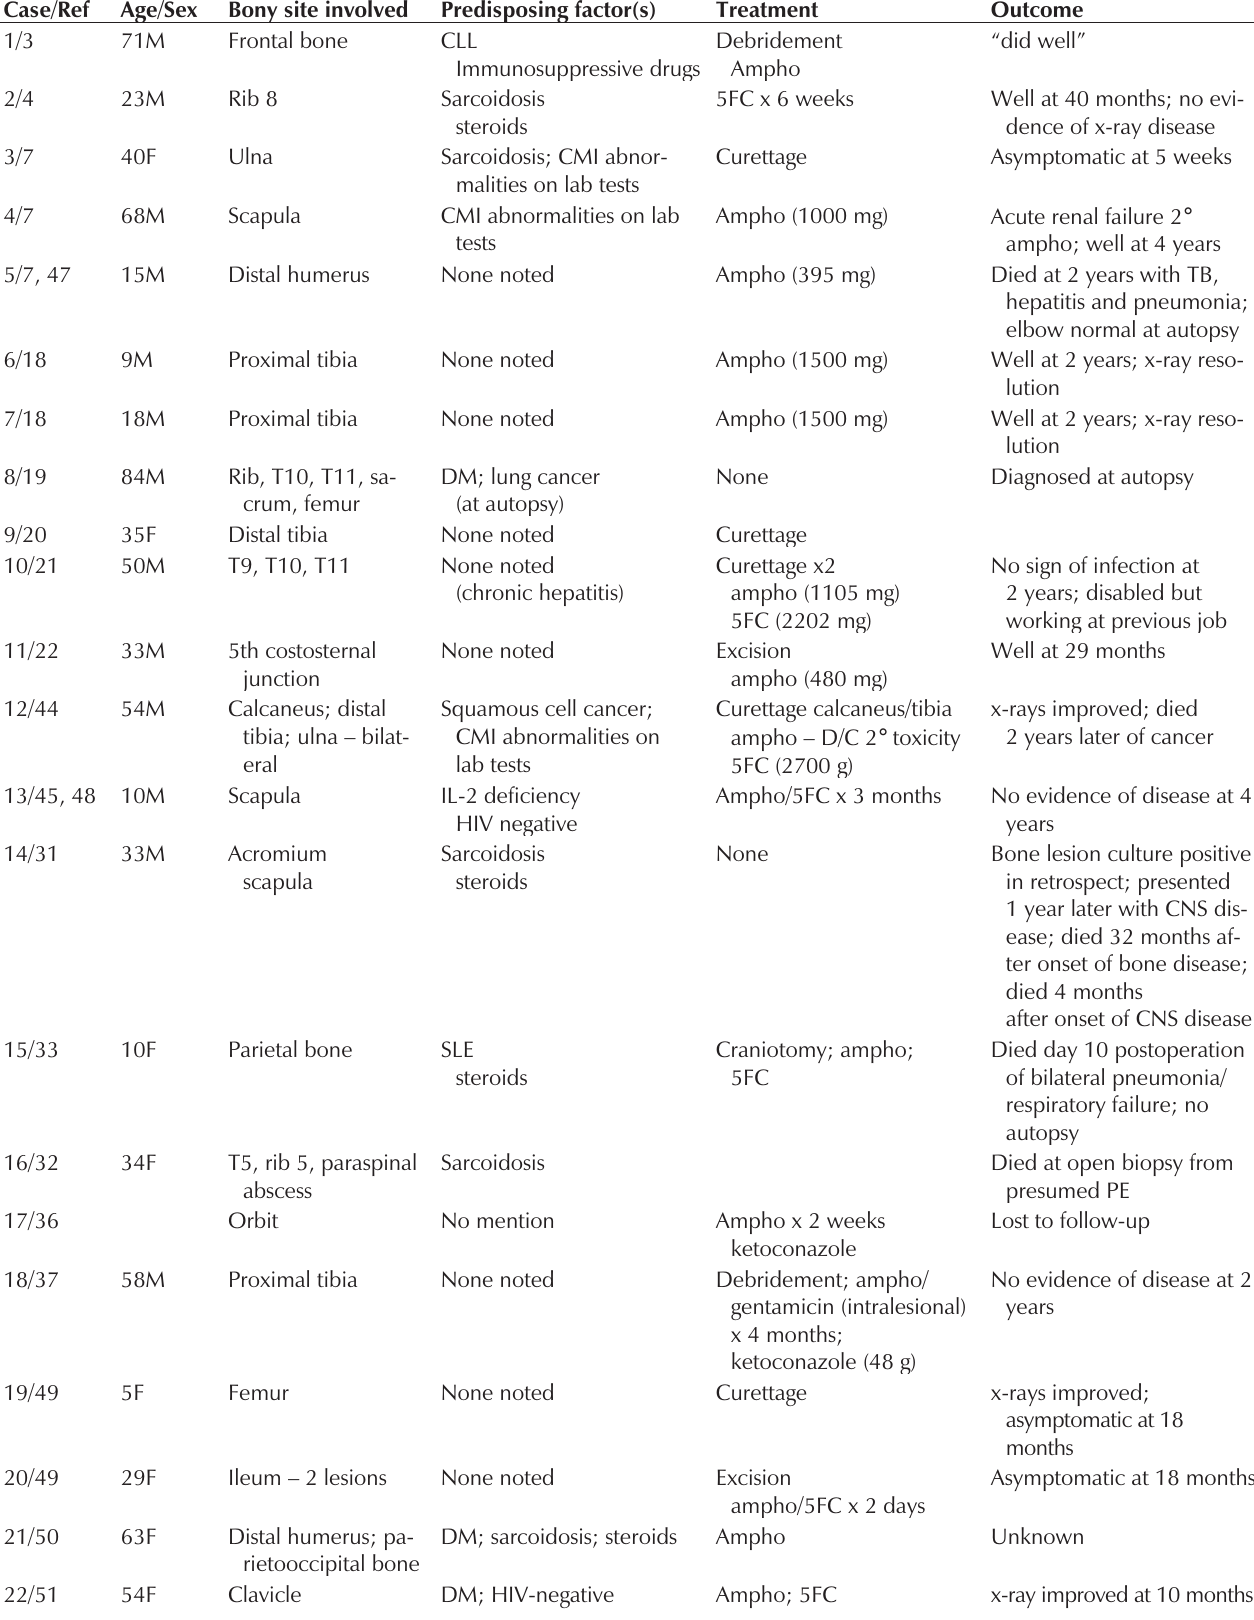
TABLE 1 Summary of 45 cases of isolated skeletal cryptococcosis from 1956 to 1995